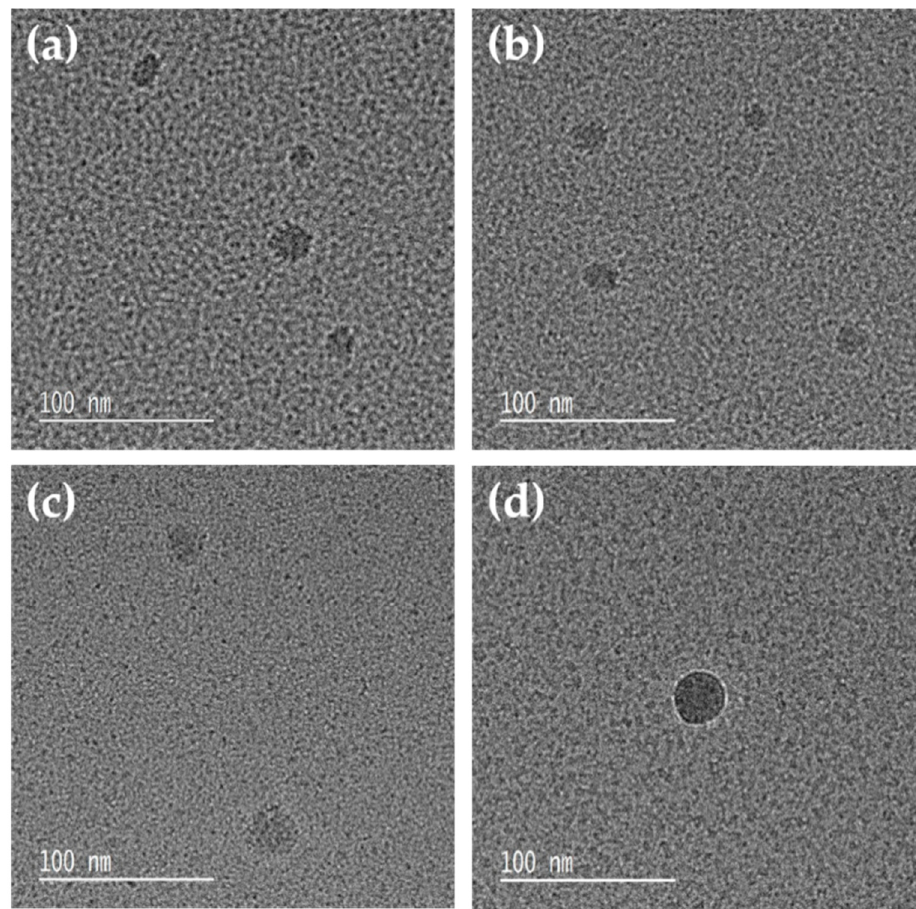
Figure 5. TEM images of silicon oxide particles captured on the pure carbon membrane for 10 s after delay times of ( a ) 0 min, ( b ) 2 min, ( c ) 7 min, and ( d ) 30 min using the quartz tube without the conical nozzle.